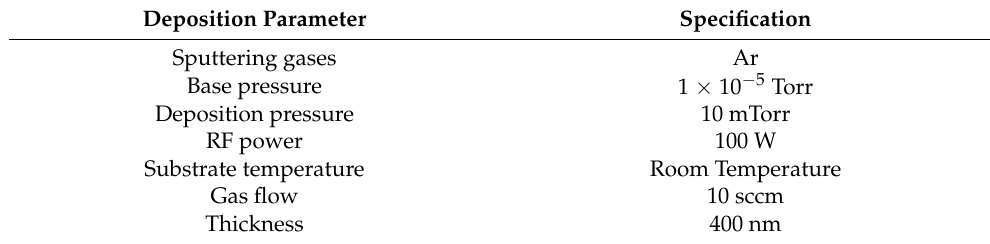
Table 2. Deposition parameters maintained during deposition of ITO thin films.